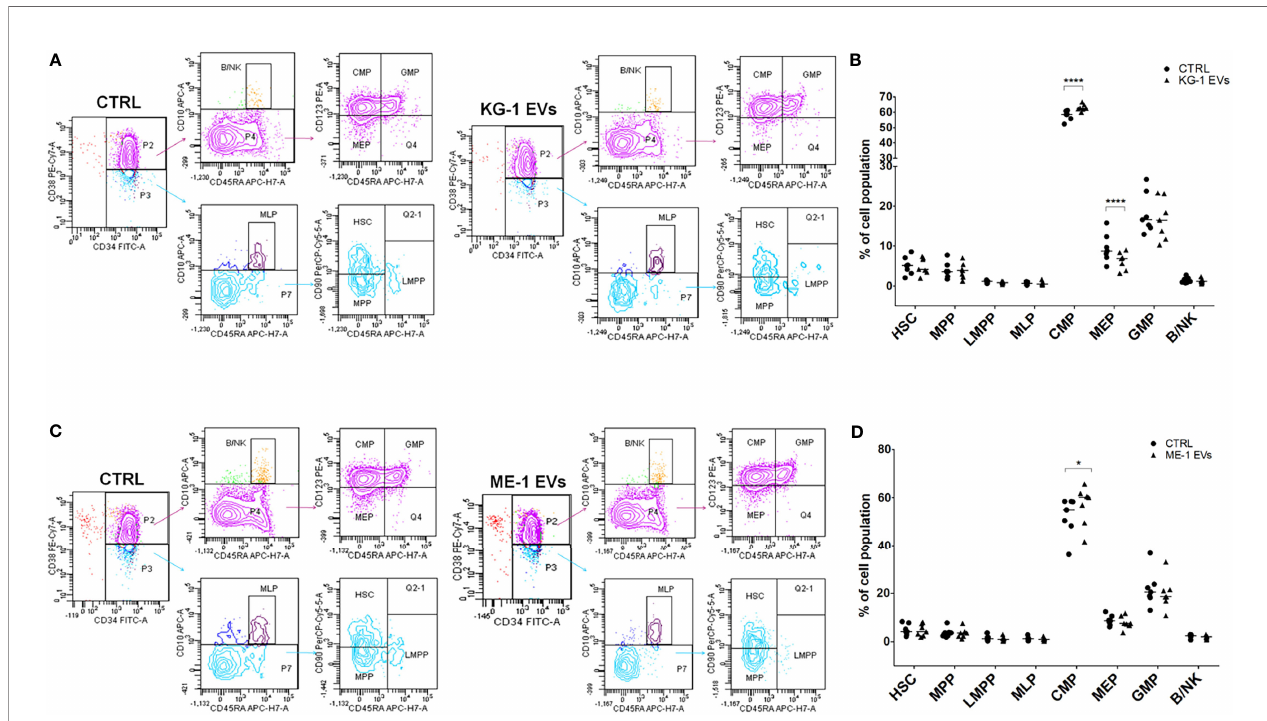
FIGURE 2 | AML-EV effects on HSPC differentiation. (A – C) Representative cyto fl uorimetric dot plots of different stem progenitor populations [hematopoietic stem cells (HSC), multipotent progenitors (MPP), lymphoid-primed multipotent progenitors (LMPP), multi-lymphoid progenitors (MLP), common myeloid progenitors (CMP), granulocyte-macrophage progenitors (GMP), megakaryocyte-erythroid progenitors (MEP) and B and NK cell progenitors (B/NK)] treated or not (CTRL) with KG-1 and ME-1 derived-EVs for 20 h. (B – D) Percentage of cell populations after treatment with KG-1 and ME-1 derived-EVs. Each symbol represents a single experiment and horizontal bars represent median values. Statistically signi fi cant analyses are indicated by asterisks: * p < 0.05 and **** p <